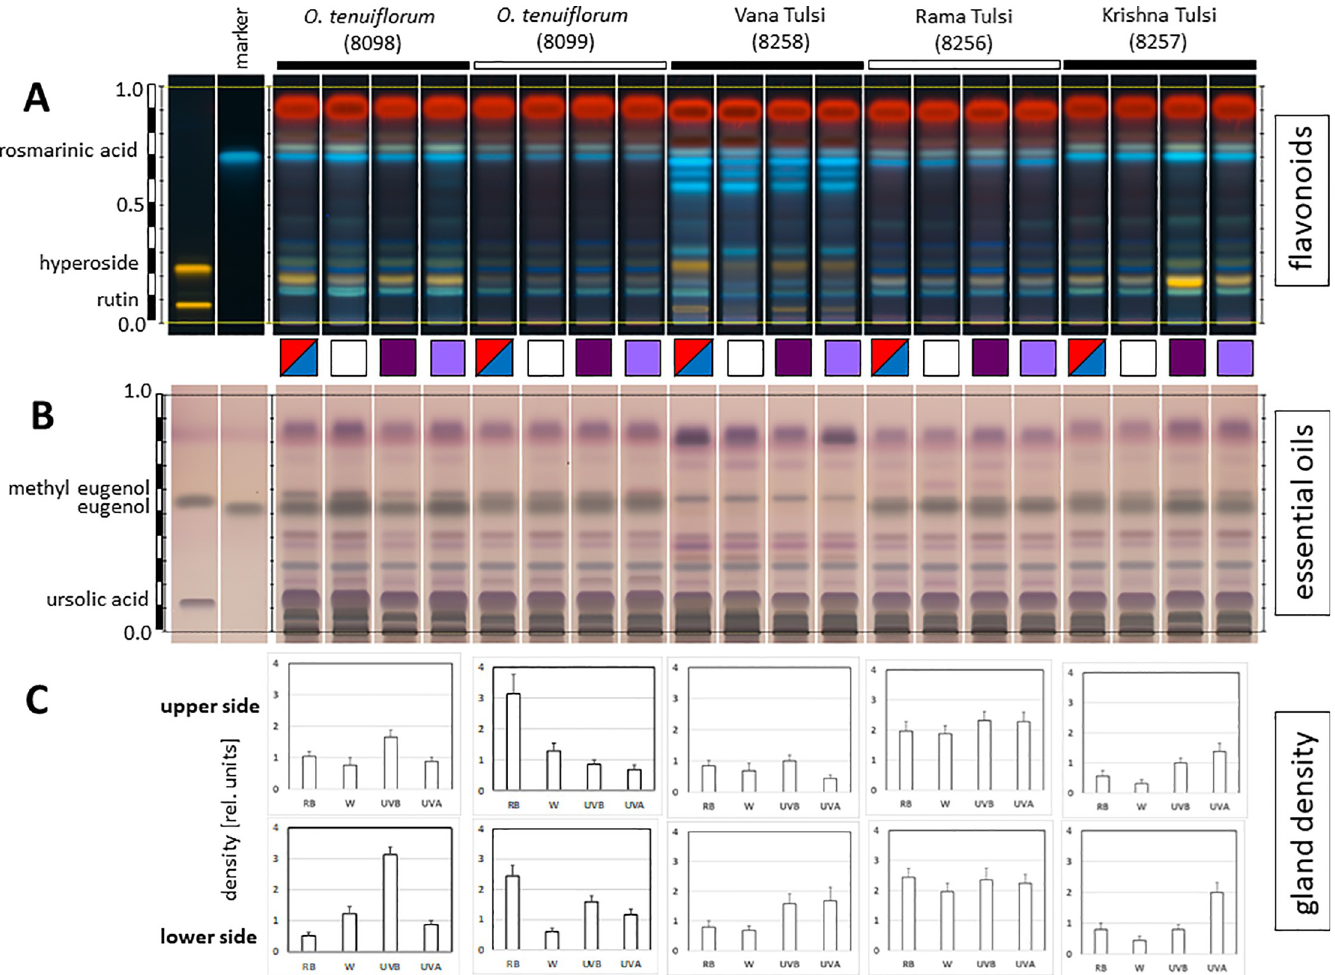
Fig 5. Effect of light quality on chemical profiles and glandular scale number in Ocimum tenuiflorum , ‘Rama Tulsi’, ‘Krishna Tulsi’, and ‘Vana Tulsi’ accessions raised side by side in the greenhouse under equal fluence rates (108 μ M . sec -1. m -2 ± 30 μ M . sec -1. m -2 ) of either white light (WL), white light supplemented with red and blue light (655 nm, 447 nm, RB), long-wavelength UV (365 nm, UVA) or short-wavelength UV (310 nm, UVB) over six months. Flavonoids ( A ) and essential oils ( B ) were probed by HT-TLC along with reference standards (in case of flavonoids, rutin and hyperoside, in case of essential oils methyl eugenol and ursolic acid). Profiles for one accession are shown side by side, indicated by colour symbols (RB, red-blue squares, WL white squares, UVB dark-violet squares, UVA light-violet squares). C mean densities of glandular scales on the upper, adaxial, and the lower, abaxial, side of fully expanded leaves given in relative units. Data represent mean values and standard errors from two independent experimental series comprising each three individual plants per accession and ten leaves per plant for each genotype.